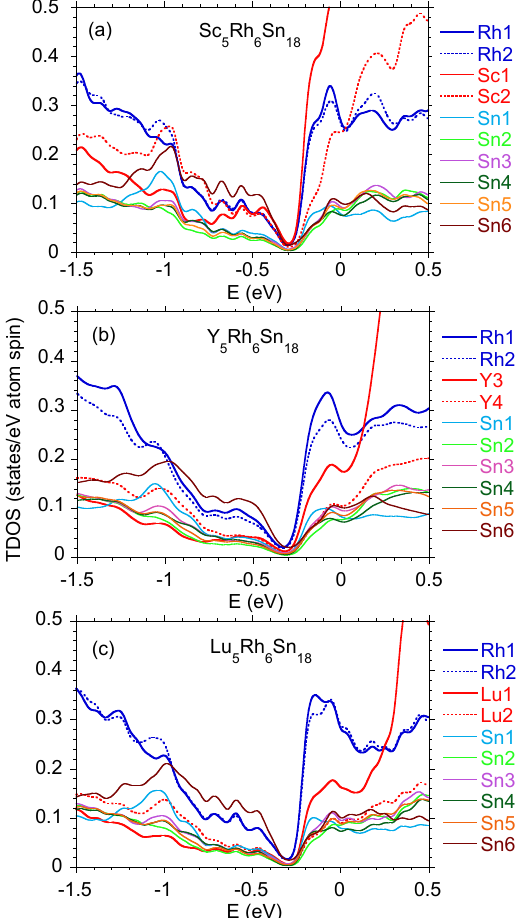
Figure 4. Partial (total) DOS per one atom for Sc 5 Rh 6 Sn 18 ( a ), Y 5 Rh 6 Sn 18 ( b ), and Lu 5 Rh 6 Sn 18 ( c ),